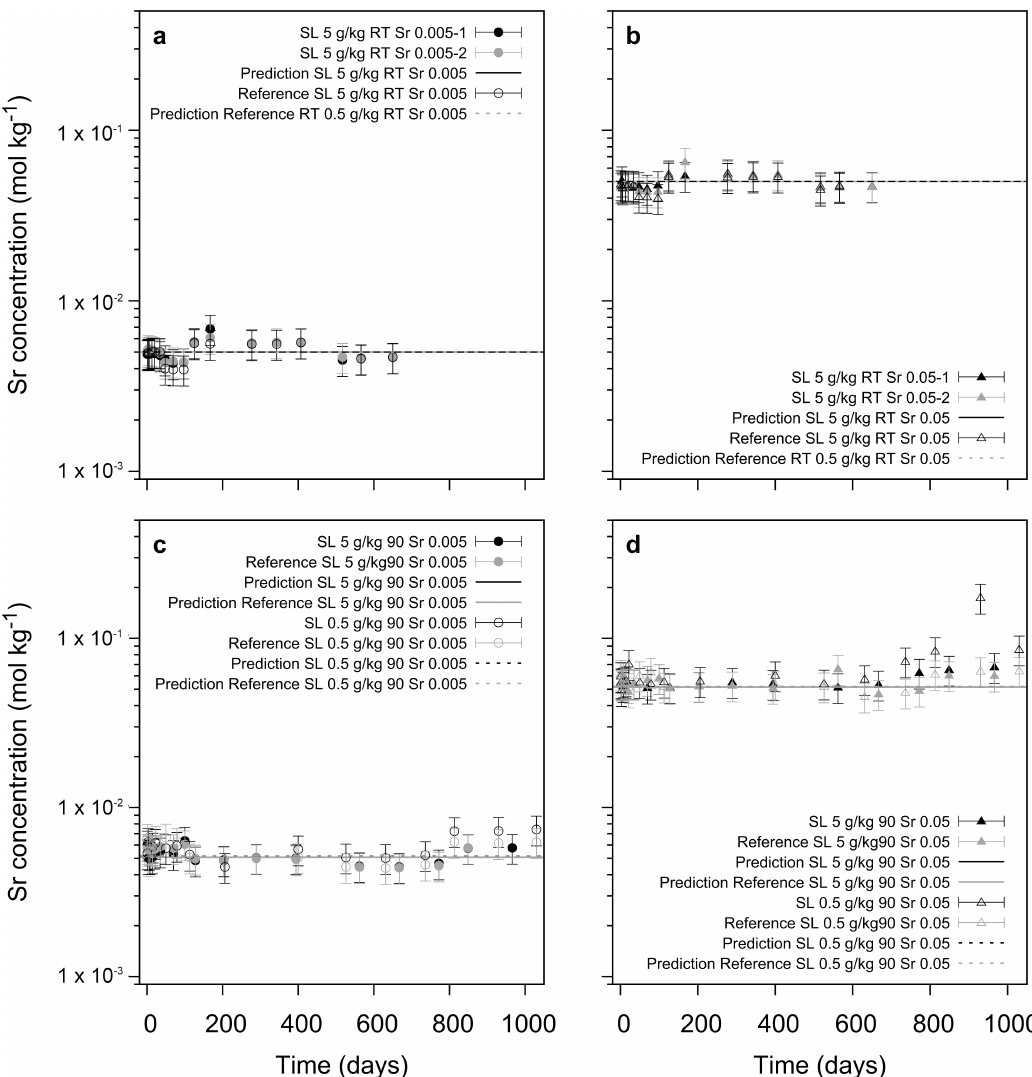
Figure 5. Temporal evolution of aqueous Sr aq concentrations at room temperature ( a , b ) and 90 ◦ C ( c , d ). Left column: experiments with 0.005 mol/kg Sr and right column: experiments with 0.05 mol/kg Sr in the aqueous solution. The lines indicate predicted concentrations calculated by